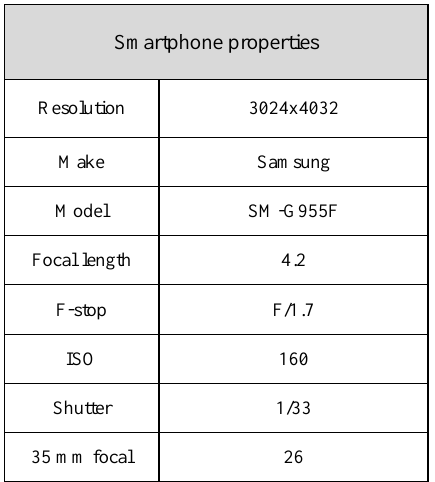
Table 2. S8 plus general specs.